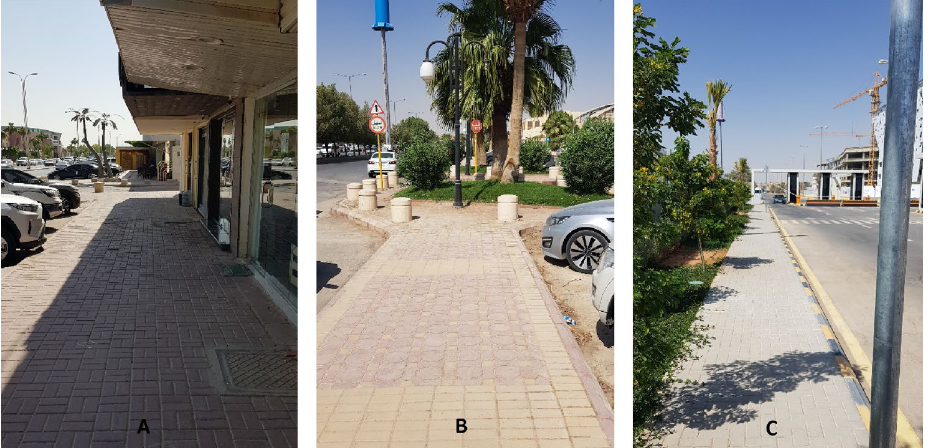
Figure 9. Examples for the street status “Passable for mobility but requires minor attention” of type M, where ( A , B , C ) are for location points 1, 3, and 19, respectively (See Fig. 5).